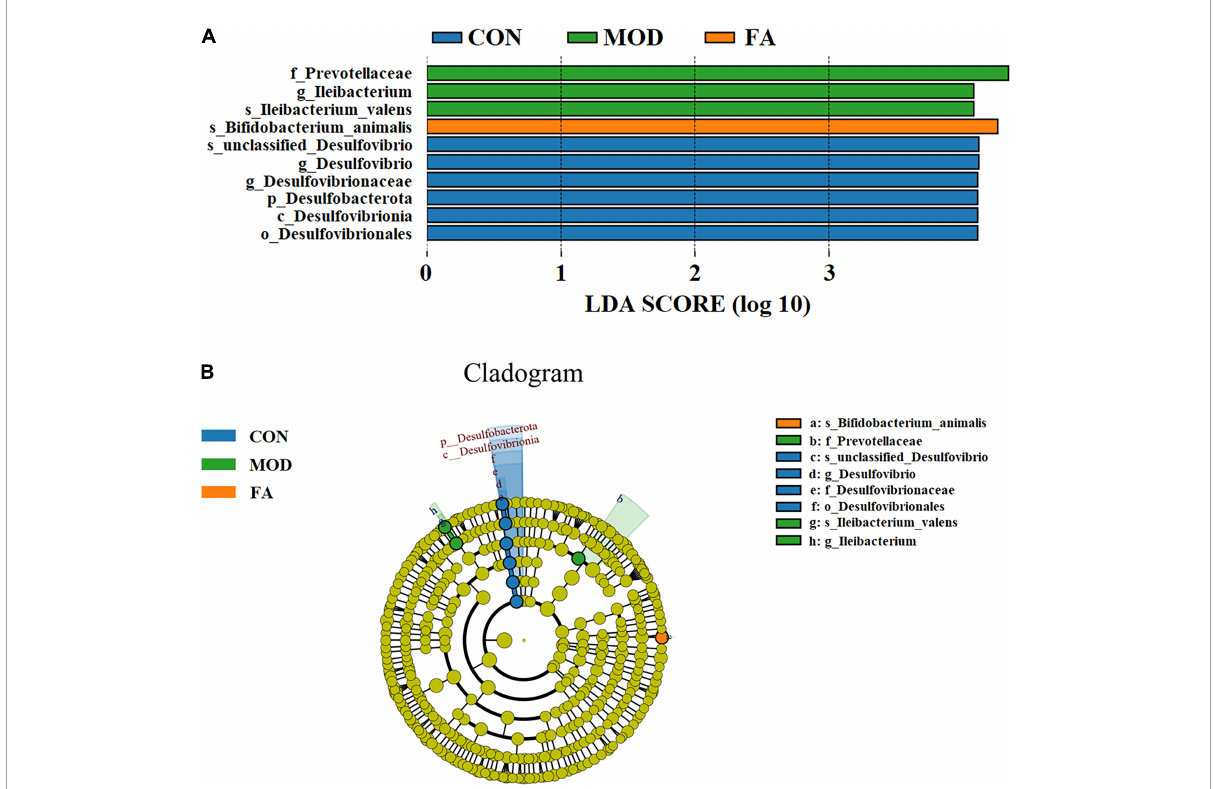
FIGURE7 LEfSe analysis. (A) Histogram of LDA score distribution (LDA score > 4.0); (B) LDA effect size of key bacteria of gut microbiota ( n = 5/group).